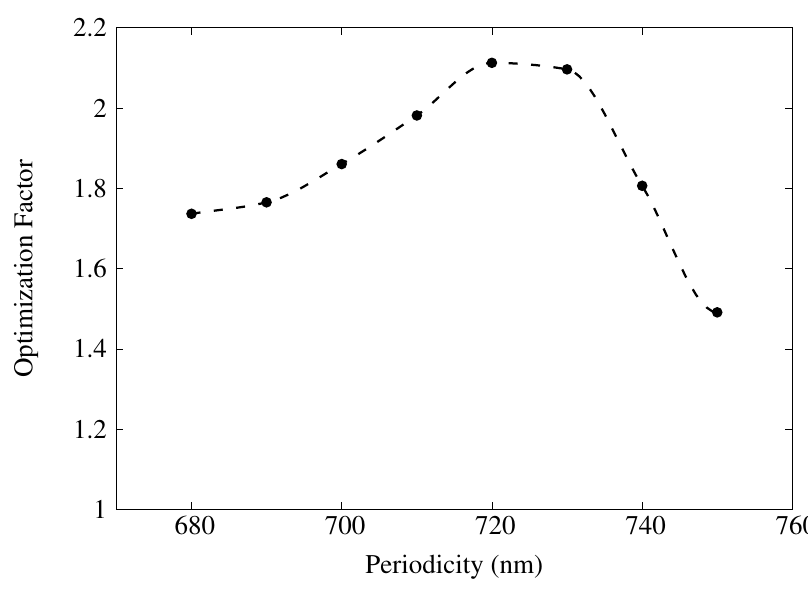
Figure 6. Plot of optimization factor, O.F. , as a function of periodicity for cylindrical NP geometry with RD = 210 nm, D = 200 nm, and MT = 24 nm in the range 680–750 nm. Dashed lines correspond to spline interpolation between data points and are meant for ease of visualization